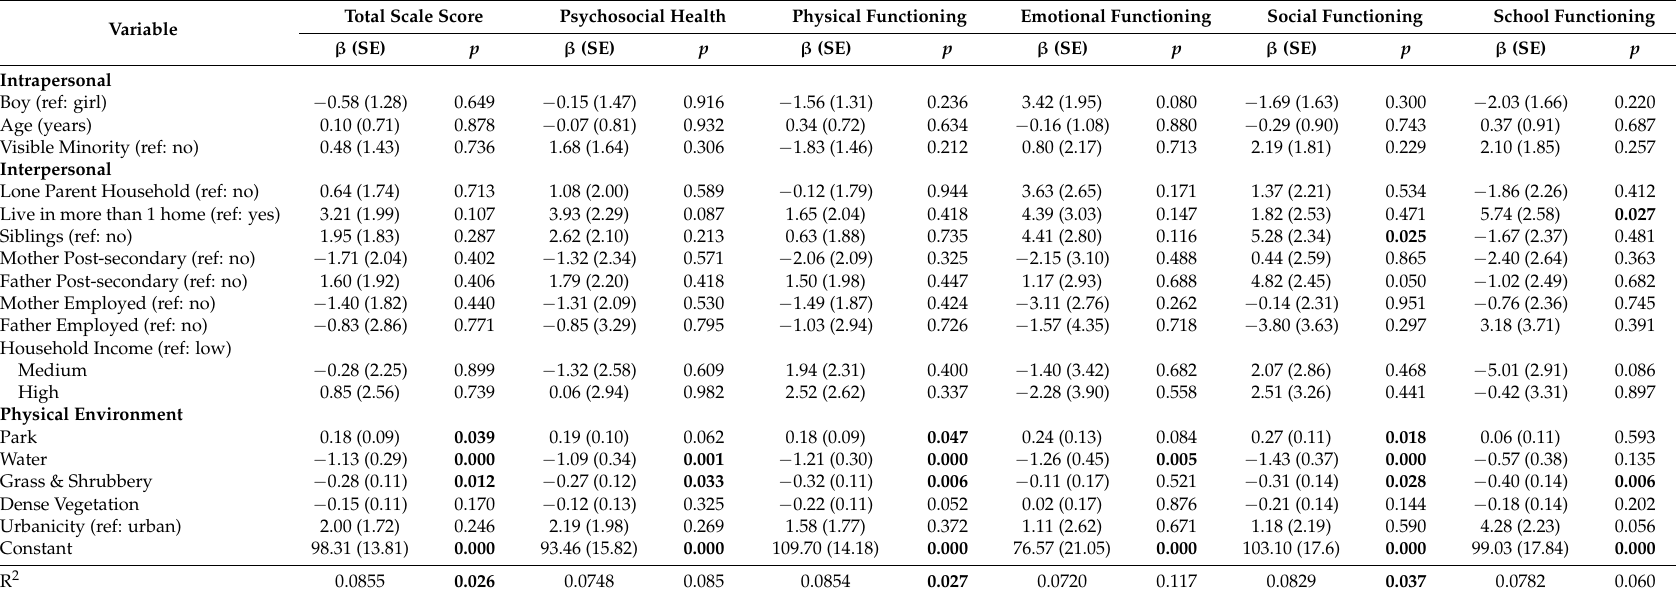
Table 3. Results of full models assessing associations between all independent variables and HRQOL indices at a 500M buffer in the urban/suburban population.